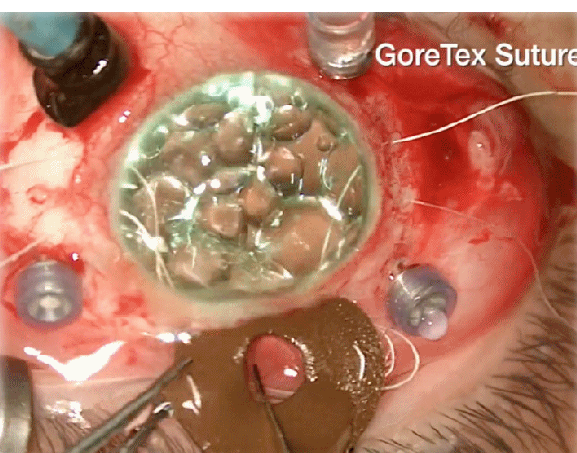
Figure 3: Surgical procedure with implantation of the Akreos ®